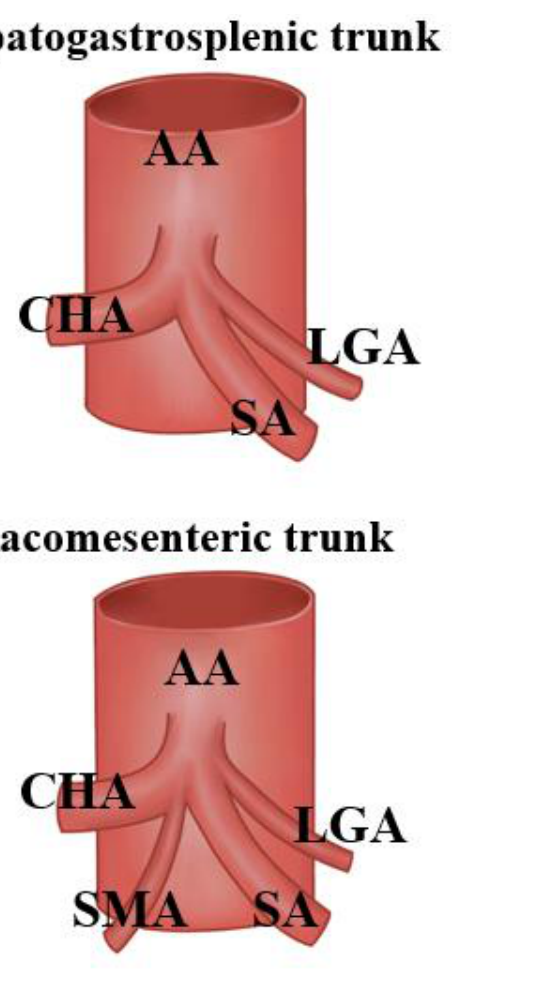
Figure 5. Celiac trunk trifurcation types according to Adachi. Abbreviations: common hepatic artery (CHA), left gastric artery (LGA), splenic artery (SA), superior mesenteric artery (SMA).